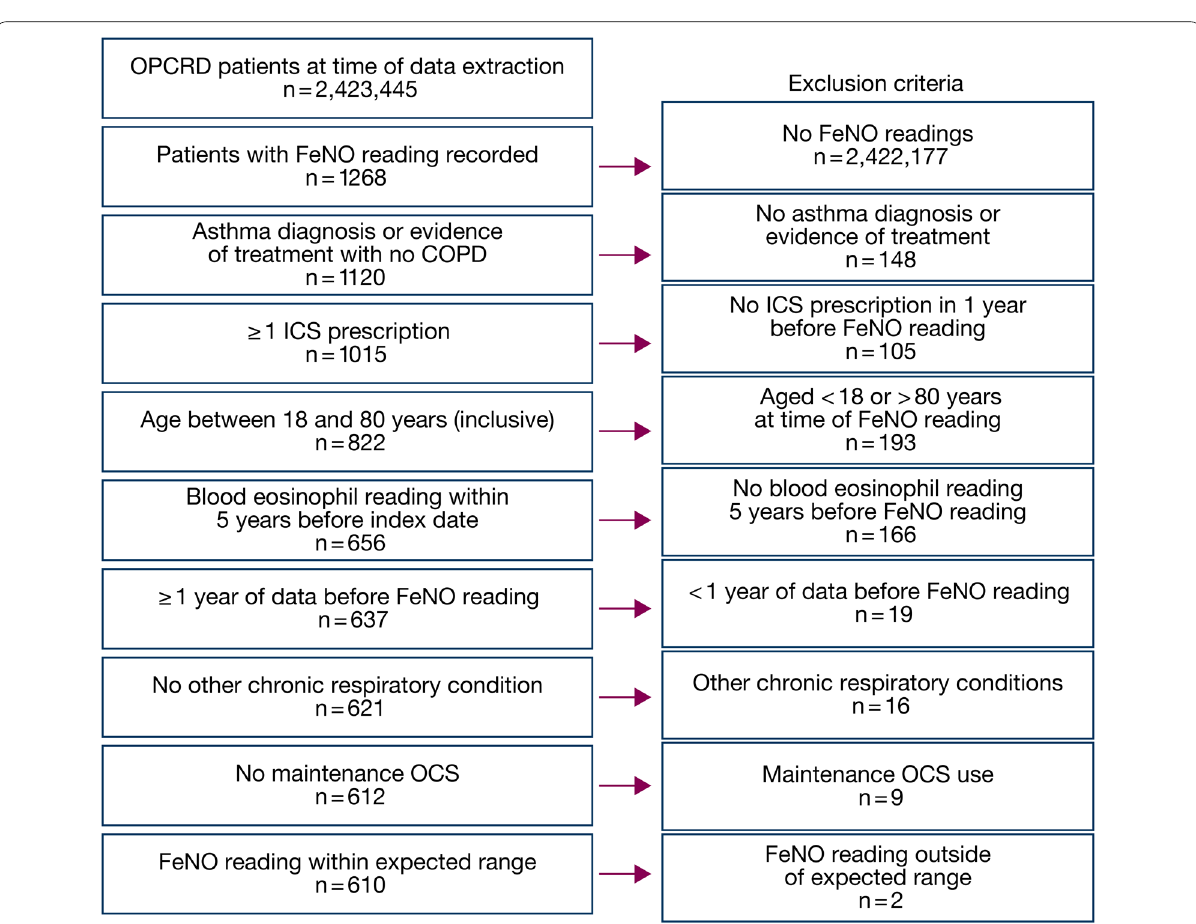
Fig. 2 Patient selection from OPCRD. COPD chronic obstructive pulmonary disease, FeNO fractional exhaled nitric oxide, ICS inhaled corticosteroid, OCS oral corticosteroid, OPCRD Optimum Patient Care Research